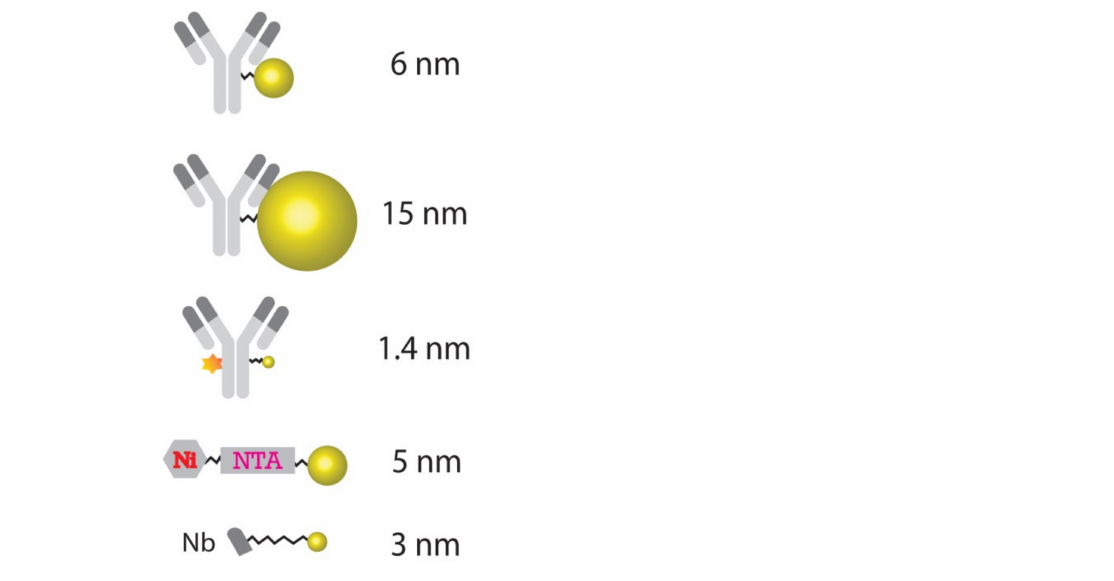
Figure 1. Schema of Au-based probes measured by nanoSIMS. Secondary antibodies were conjugated to Au_Np (ball) with a size of 6 nm, 15 nm and 1.4 nm, and the 1.4 nm-conjugated antibody was additionally conjugated to a fluorophore (star). The nanobody (Nb) was conjugated to 3 nm Au_Np. All of them enable the affinity labeling of target molecules. The 5 nm Au_Np can be attached to His-tagged proteins through the binding of its conjugated nickel-NTA to